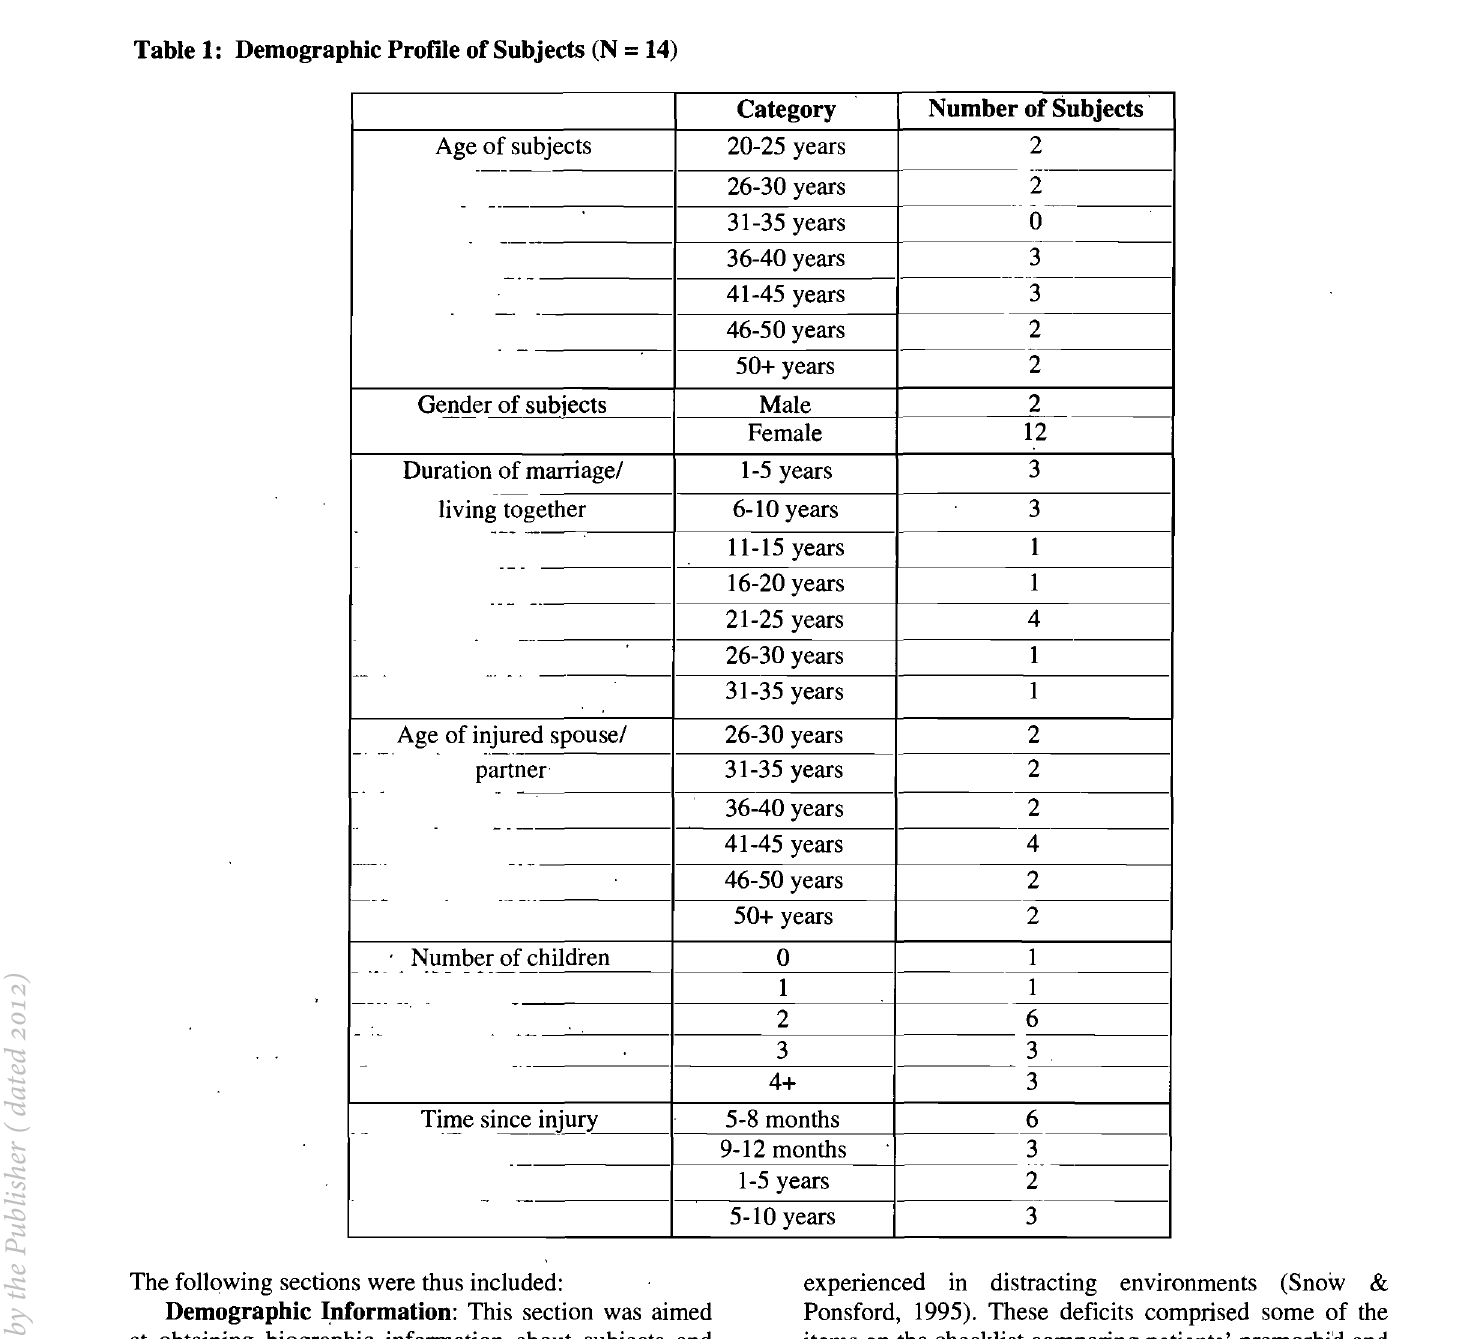
Table 1: Demographic Profile of Subjects (N =